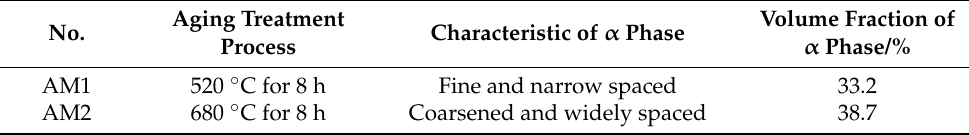
Figure 1. SEM and EBSD images of the alloy: ( a ) SEM, aged at 520 ◦ C for 8 h; ( b ) SEM, aged at 680 ◦ C for 8 h; ( c ) EBSD, aged at 520 ◦ C for 8 h; ( d ) EBSD, aged at 680 ◦ C for 8 h. Table 2. Microstructural characteristic of α phase in the aged alloys.